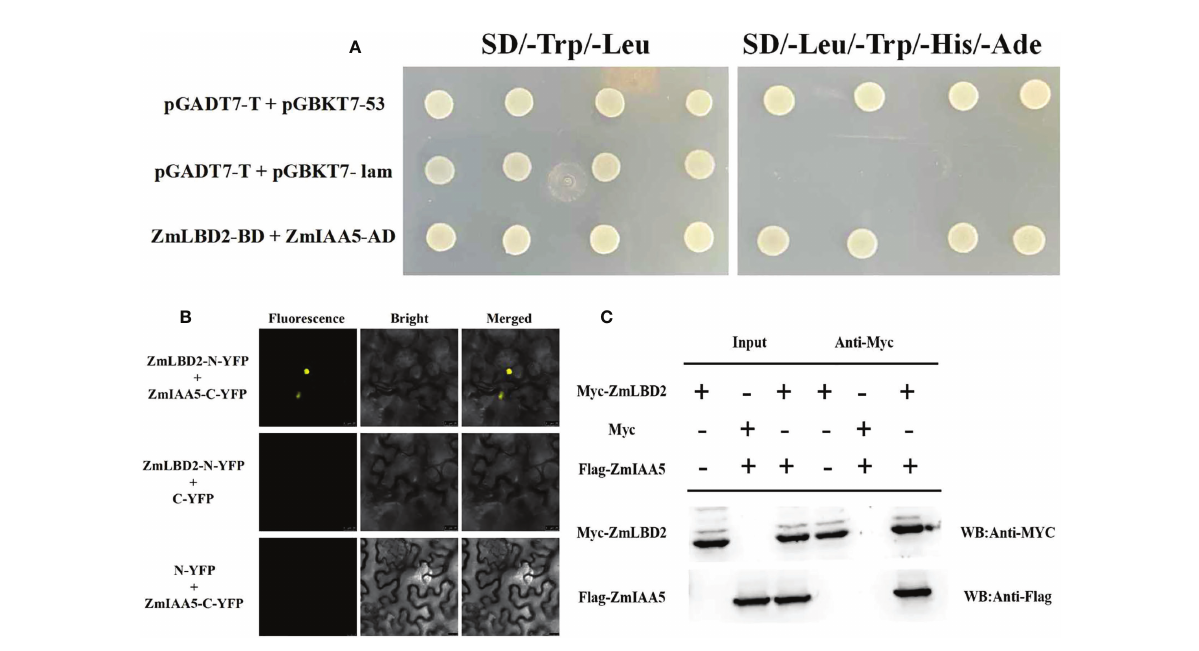
FIGURE 12 Interaction between ZmLBD2 and ZmIAA5. (A) Interaction analysis of ZmLBD2 and ZmIAA5 using a yeast two-hybrid system. (B) Interaction of ZmLBD2 and ZmIAA5 as determined with a BiFC assay. (C) Pull-down assay ofZmLBD2 and